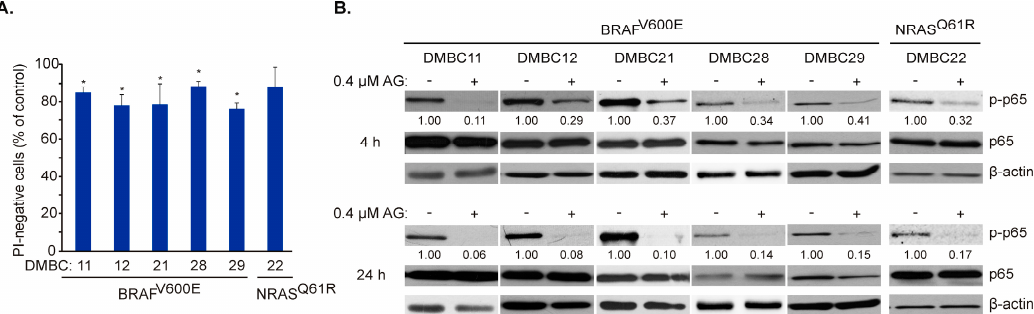
Figure 3. 17-Aminogeldanamycin (AG) inhibits the activity of p65/NF- κ B in melanoma cell lines of the BRAF V600E or NRAS Q61R subtypes before it substantially affects cell viability. ( A ) Cells were incubated with AG at 0.4 µM for 24 h. Propidium iodide (PI)-negative (viable) cells were assessed by flow cytometry and expressed relative to the control. Data presented are mean ± SD; n = 3 (* p ≤ 0.05 vs. control). ( B ) Levels of phosphorylated p65 (p-p65) and total p65 were determined by Western blotting after 4 and 24 h. β -actin was used as a loading control. The relative level of p-p65 versus β -actin is shown below the blots.